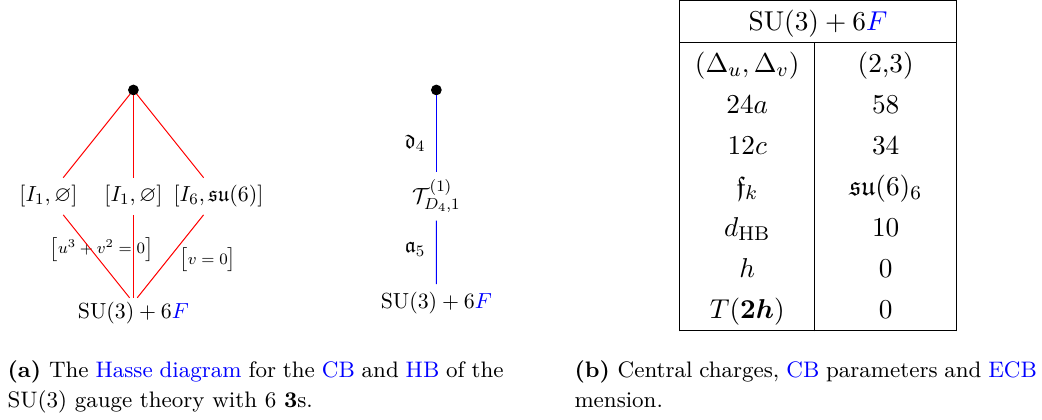
Figure 8. Information about the SU(3) N = 2 theory with 6 hypermultiplets in the 3